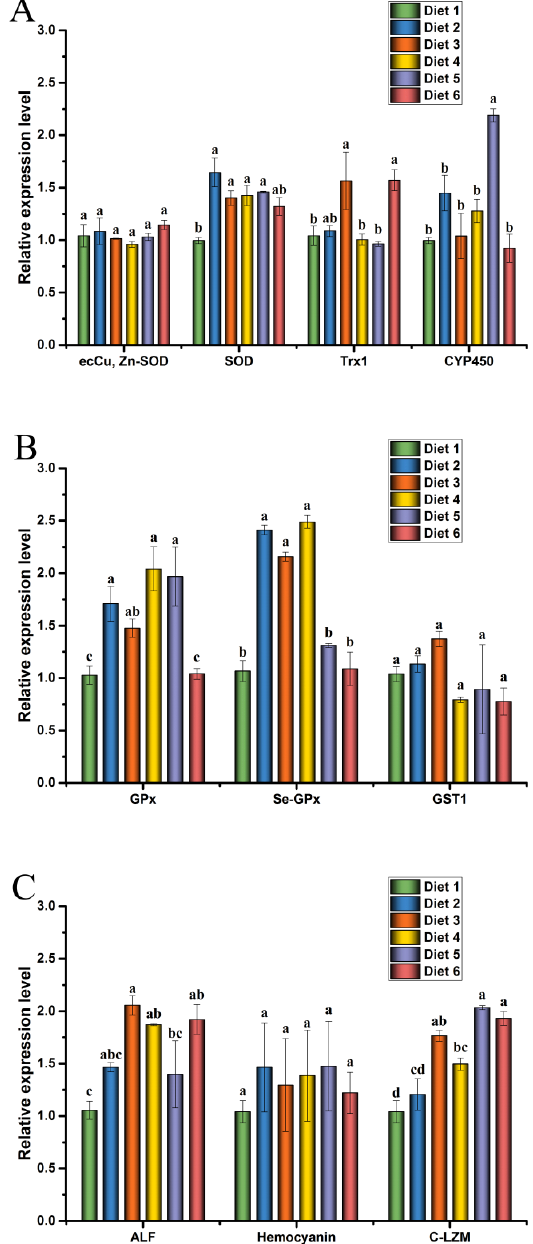
Figure 2. Effects of dietary ELE on antioxidant ( A ), glutathione metabolism ( B ) and immunity ( C ) gene expression levels in hepatopancreas of Cherax quadricarinatus . Different letters above the error line indicate significant differences ( p < 0.05). Relative expression levels of GPx, selenium-dependent glutathione peroxidase (Se-GPx), and glutathione-s-transferase 1 (GST1) in crayfish are presented in Figure 2B. The relative expression levels of GPx mRNA in the hepatopancreas were significantly increased in Diet 2, Diet 3, Diet 4, and Diet 5 groups compared with the control group ( p < 0.05). The mRNA levels of Se-GPx were significantly up-regulated in the hepatopancreas of Diet 2, Diet 3, and Diet 4 groups than that of the control group ( p < 0.05). However, there was no significant difference in the expression of GST1 among the groups ( p ˃ 0.05).